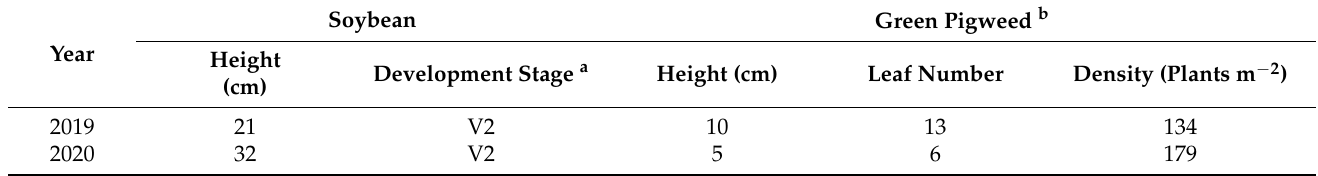
Table 2. Average soybean height and development stage and green pigweed ( A. powellii ) height, leaf number, and density at POST herbicide application timing for two trials conducted near Dresden, ON, Canada in 2019 and 2020.